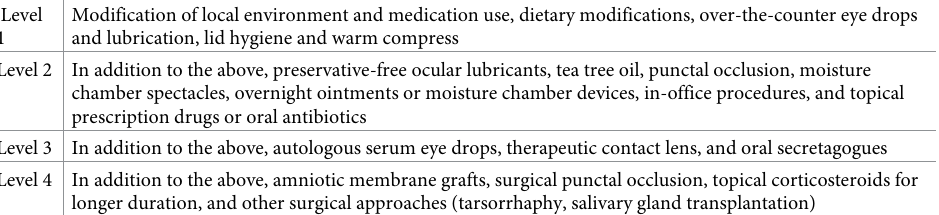
Table 1. Classification of treatment levels used according to severity of objective dry eye parameters in a longitu- dinal, clinic-based sample of patients with Sjo¨gren’s and non-Sjo¨gren’s dry eye disease. Level